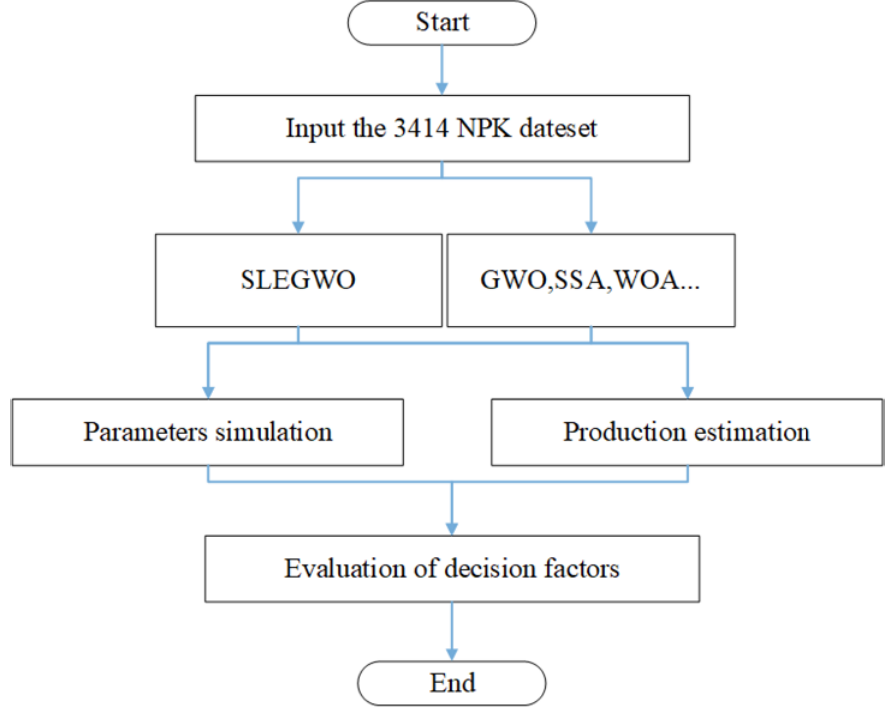
Figure 3. Flowchart of the SLEGWO and NPK precision fertilization method.